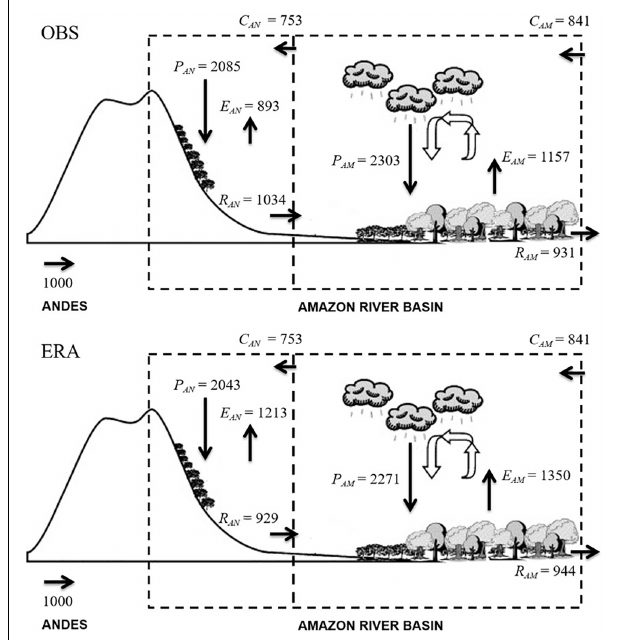
FIGURE 3 | Illustration of the components of surface water balance and atmospheric water balance based on the observations (OBS) and reanalysis (ERA) datasets in the Andes and Amazonia subregions of the Amazon River basin. P, precipitation; E, actual evapotranspiration; R, runoff; C, moisture convergence. Values are in units of mm.y − 1 . The arrow convention on the bottom left represents 1000 mm.y − 1 . Source: Builes-Jaramillo and Poveda (2018). © American Geophysical Union. Reprinted by permission from John Wiley and